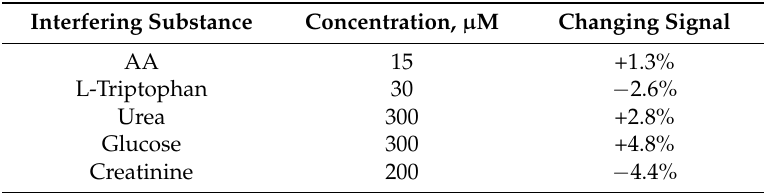
Table 2. Interference of some substances with UA signal (The signal caused by 3 µ M UA is taken as 100%).